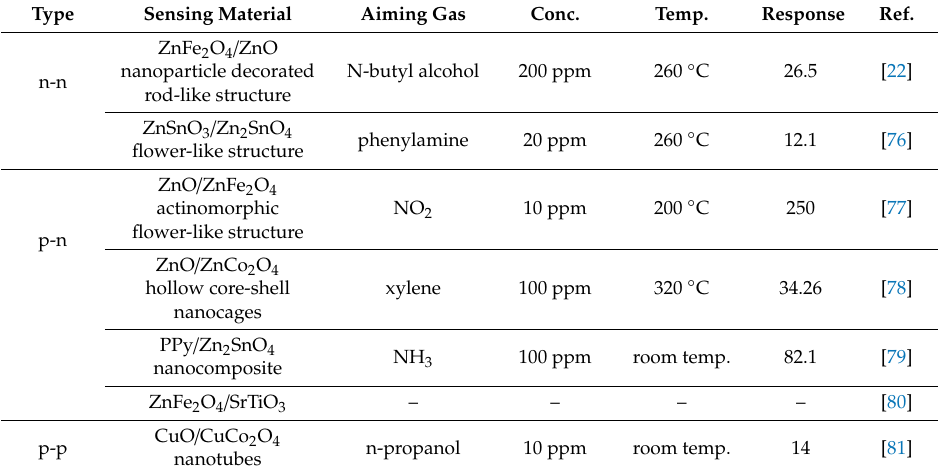
Table 2. Heterojunction structures.